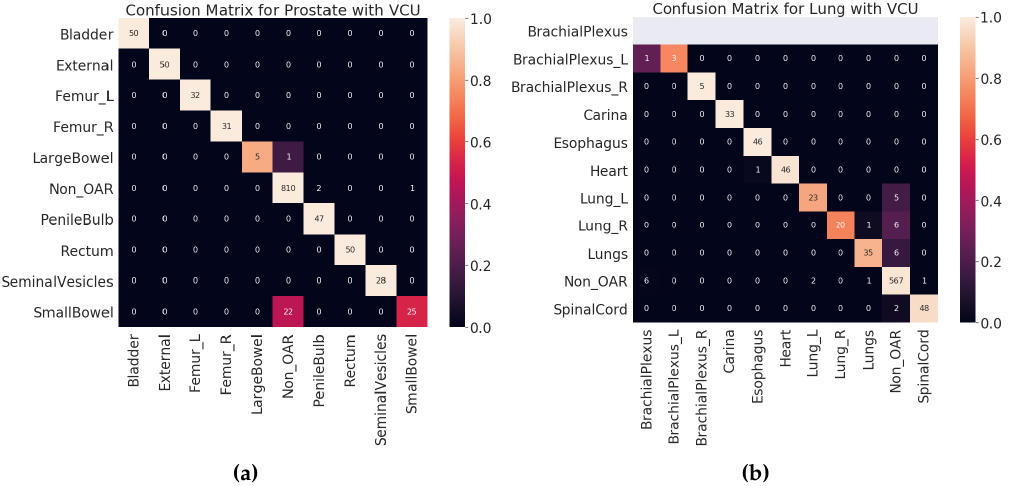
Figure 7. Test set (VCU) confusion matrices. ( a ) Prostate. ( b ) Lung. Lighter color indicates better prediction. Diagonal indicates the correctly predicted